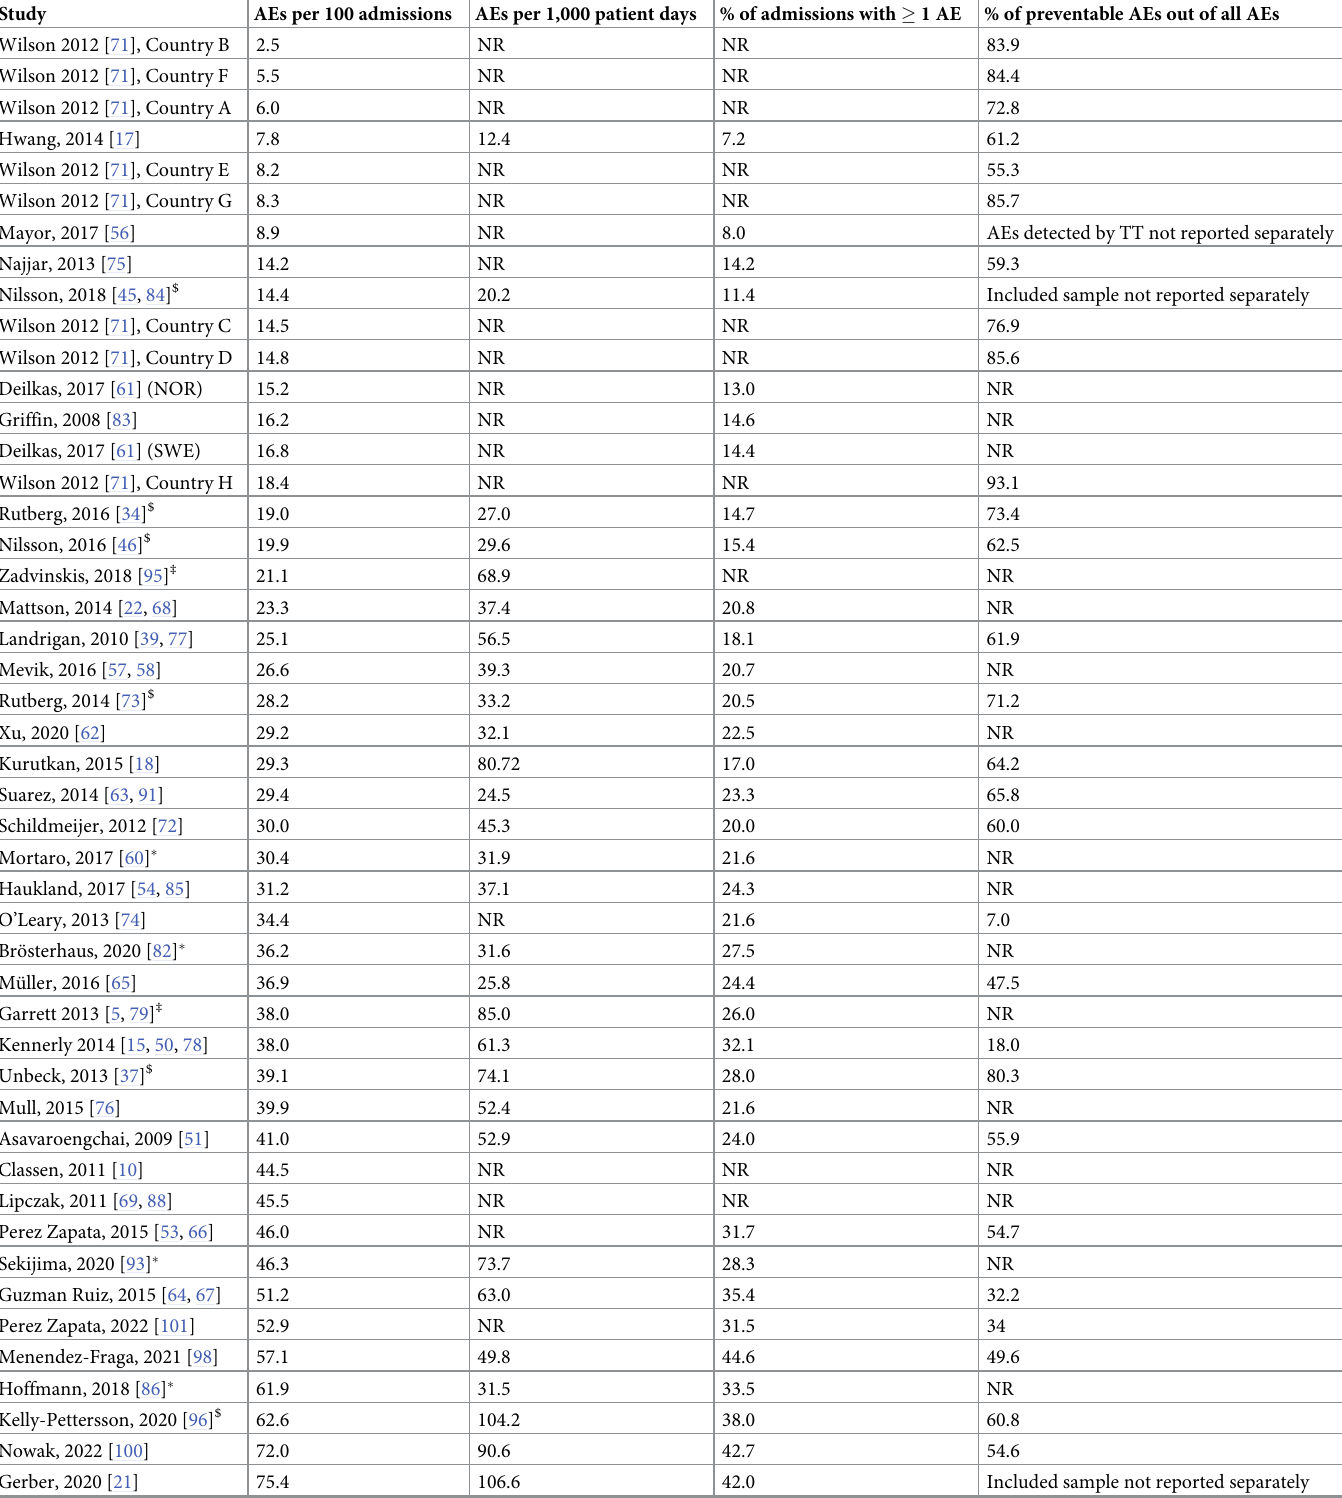
Table 3. Main characteristics of adverse events (AE) rates.